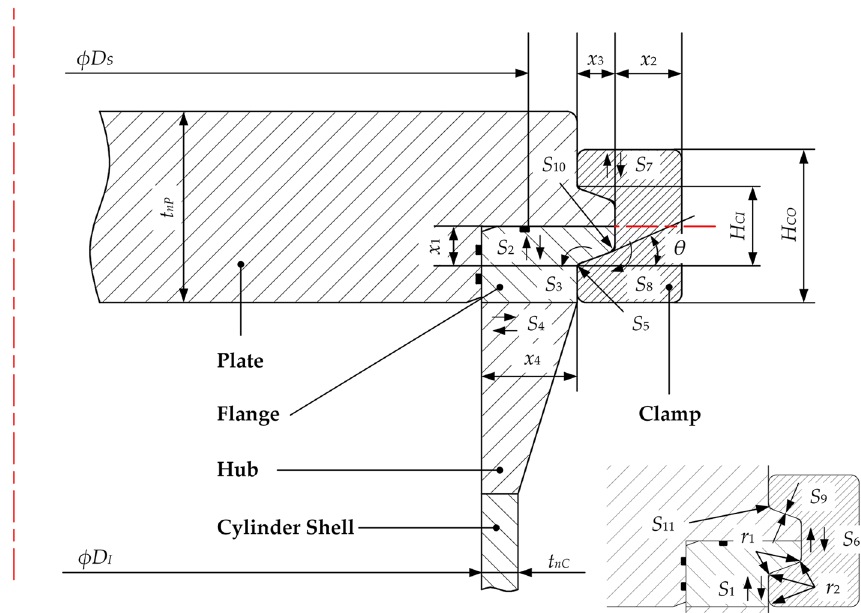
Fig. 11 The split clamp type quick closure structure for deep- ocean pressure